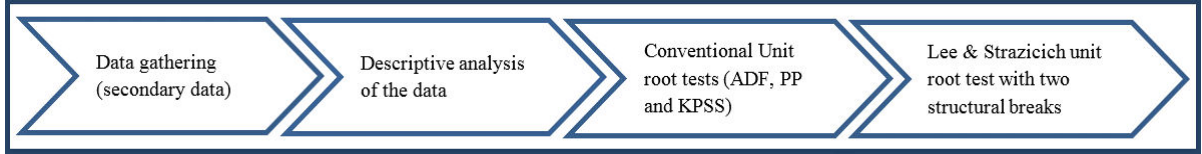
Figure 1. Flowchart of the research methodology.